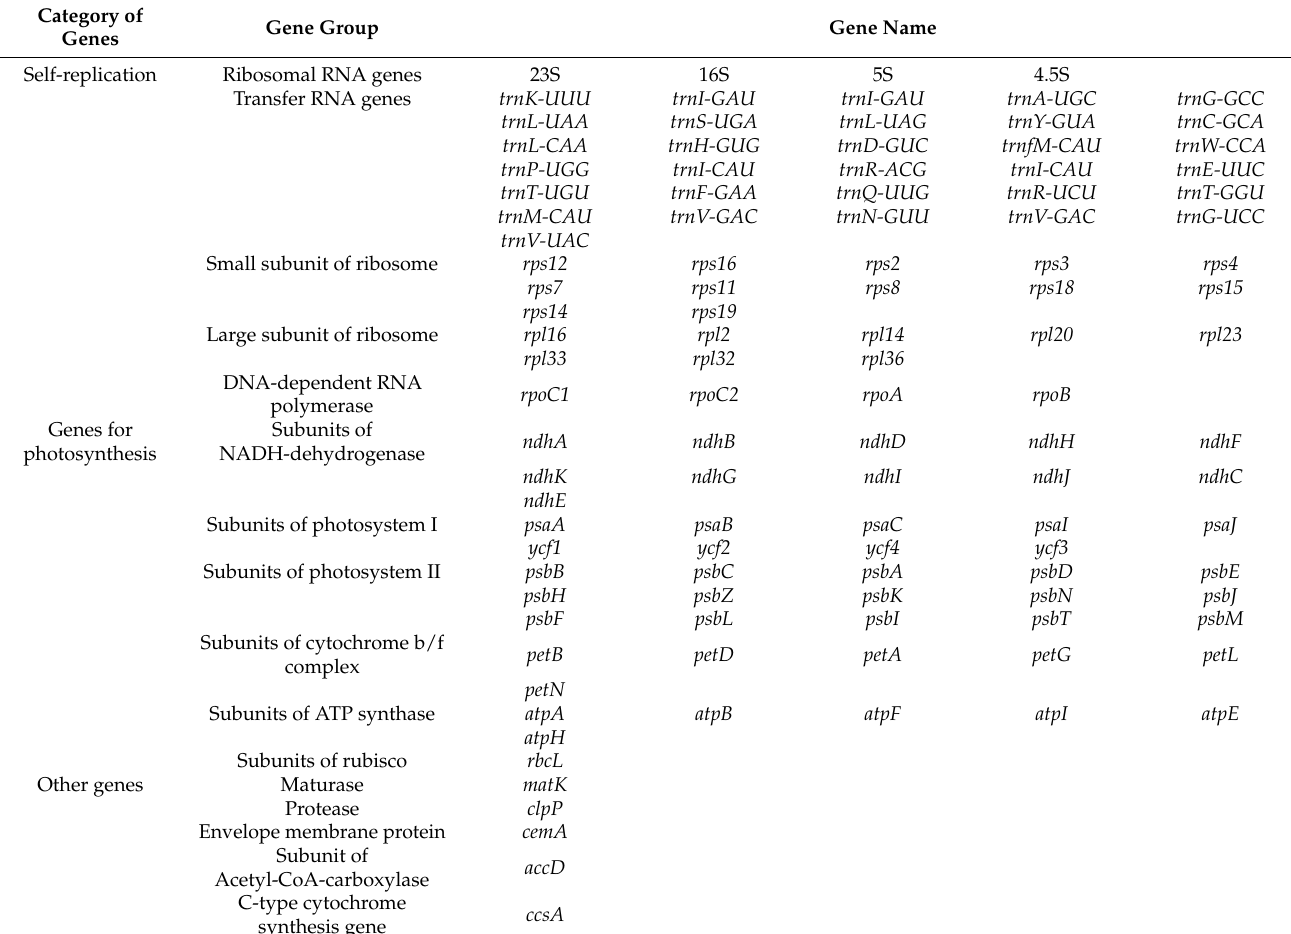
Table 2. Gene contents in eight Castanea individuals’ cp